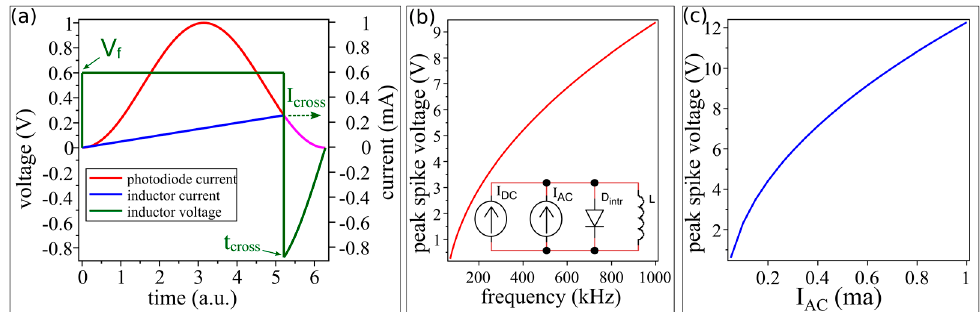
Figure 2. ( a ) Simplified operation of PFVVS; ( b ) frequency dependence of the peak value of the voltage spike produced by inductance for 4700 μ H, I AC = 0.5 mA and I DC = 0.5 mA, inset shows circuit used in analysis; ( c ) dependence of the peak value of the voltage spike produced by inductance on AC component of photocurrent for 4700 μ H inductor, f = 800 kHz and I DC = 0.5 mA.